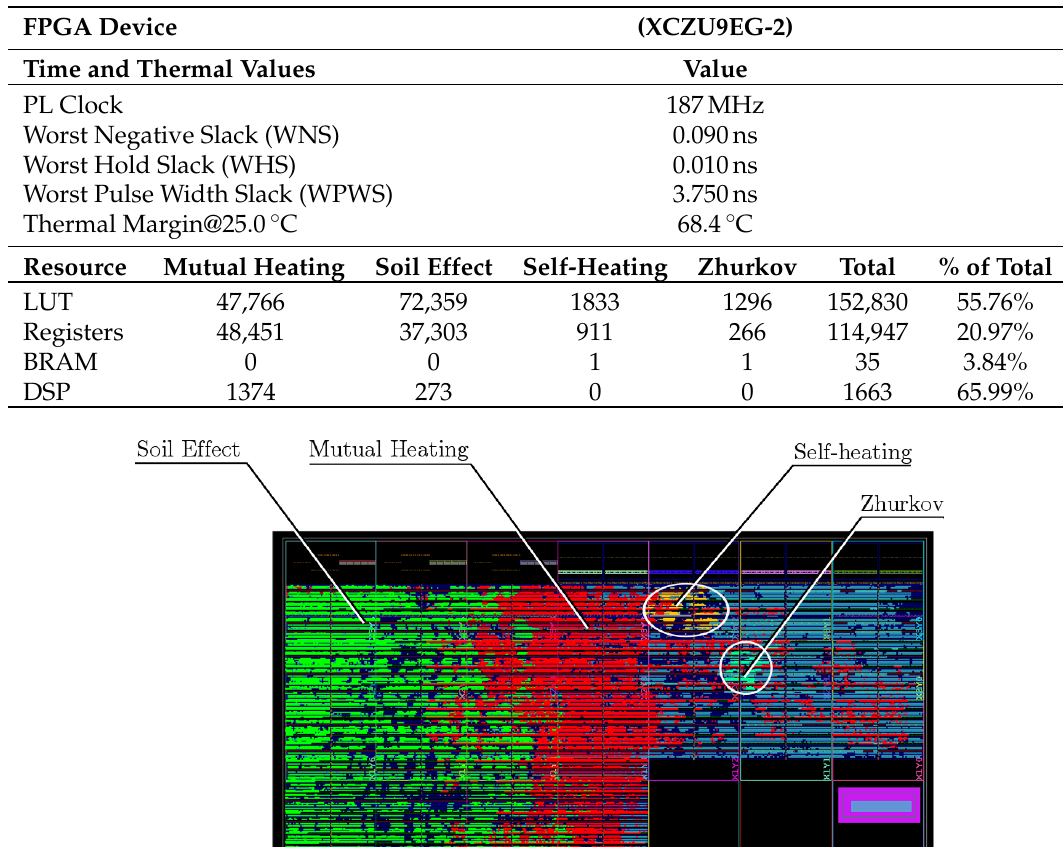
Table 1. FPGA resource use, timing, and thermal characteristics of the implementation.